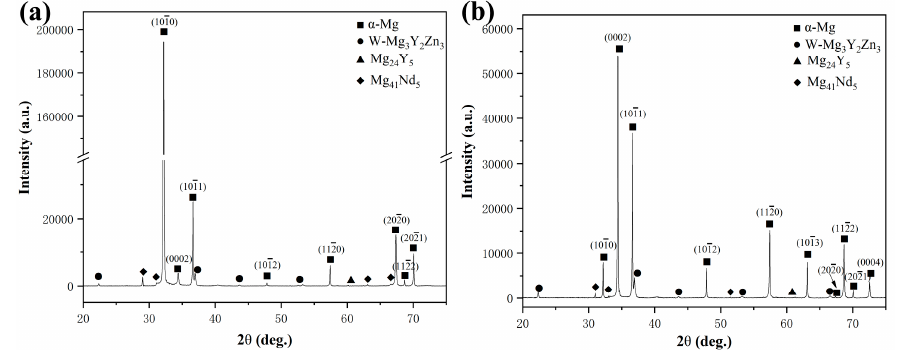
Figure 7. XRD patterns of the Mg–Zn–Y–Nd alloy with two-pass hot extrusion: ( a ) cross section of the extrude alloy (perpendicular to the extrusion direction), ( b ) longitudinal section of the extruded alloy (parallel to the extrusion direction).